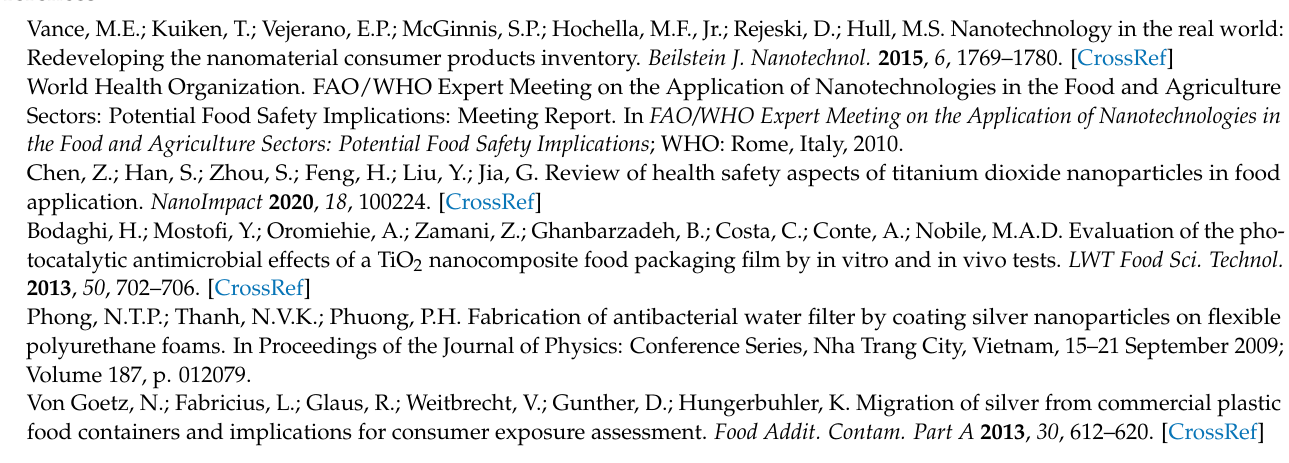
Table S2: Primer sequences for human genes, Table S3: Primer sequences for murine genes, Table S4: Estimated constitutive gene expression in pre-confluent and confluent E12 cells as well as in stable and inflamed triple cultures, Table S5: Estimated constitutive gene expression in murine ileal tissue, Figure S1: Estimated constitutive gene expression in murine ileal